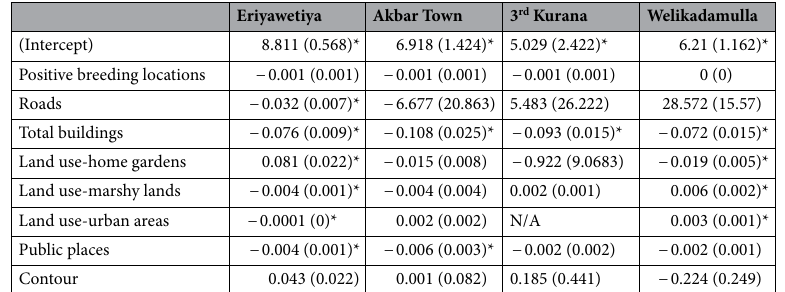
Table 2. Coefficients obtained by the Poisson point process modelling for the variables in different high risk study areas. *Significantly correlated layers with patient locations in respective Poisson point process models. Standard errors have indicated within parentheses. A 5% significance level was used to identify significant correlations. N/A-Urban areas are not included in the land use maps of 3 rd Kurana study area.